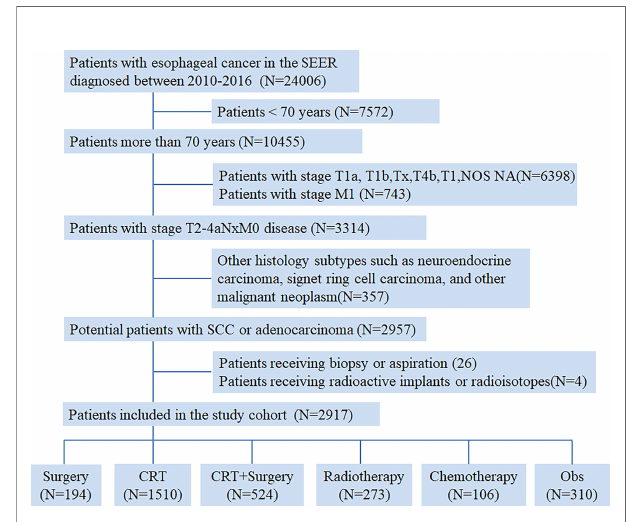
FIGURE 1 | Flow chart of patient selection from the Surveillance, Epidemiology, and End Results (SEER)